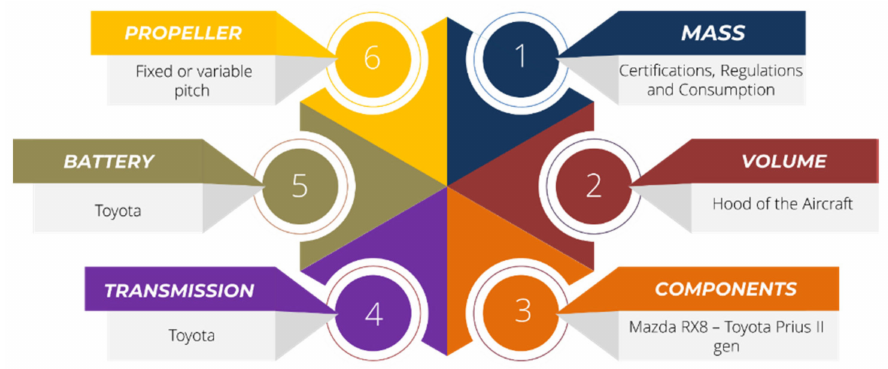
Figure 6. The technical constraints and the available technologies for the